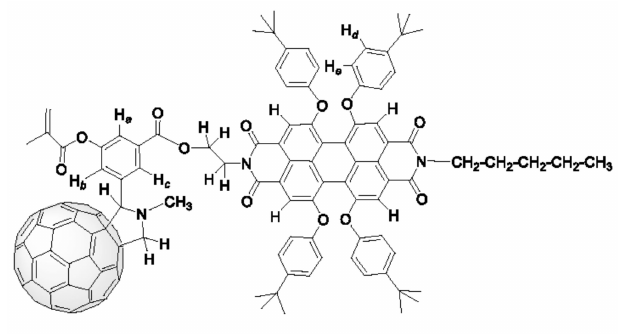
Figure 6. Formula of dyad 12 for 1 H NMR spectrum